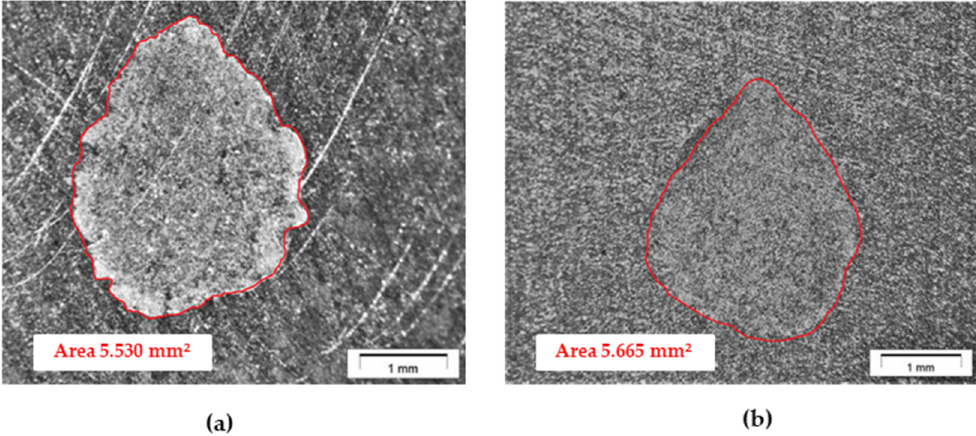
Figure 9. ( a ) Image of the contact area A (CCD9); ( b ) image of the contact area B (CCD 9).